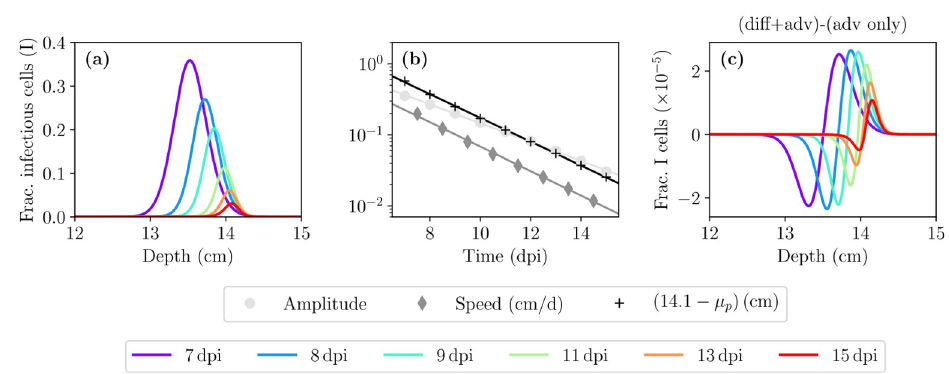
Fig 4. A closer look at infection resolution: the impact of deposition depth and diffusion. (a) A zoomed-in continuation of Fig 3(e) showing the localized fraction of infectious cells as a function of depth within the HRT, at times beyond 7 dpi. (b) The (nearly exponential) decay over time of the amplitude and speed of the Gaussian pulse of fraction of infected cells shown in (a), and of its centre location (mean, μ p ) relative to its final, asymptotic location of 14.1 cm. The points are from the MM-simulated infection, and the lines are an exponential regression (linear regression to the log of the quantities). (c) The fraction of infectious cells shown in (a) in the presence of diffusion and advection (diff+adv) minus that obtained in the presence of advection only (adv only), i.e. when D PCF =